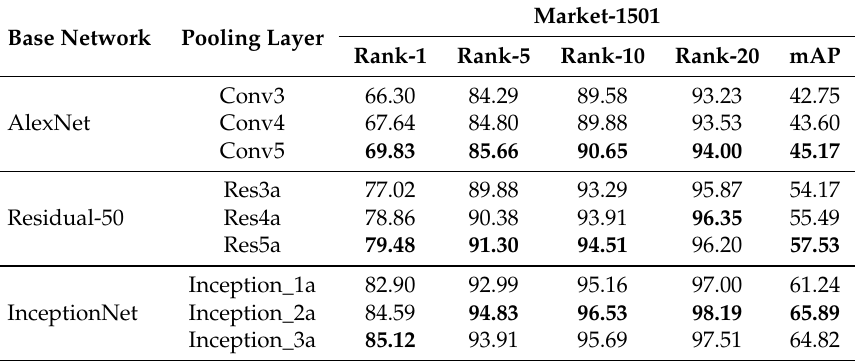
Table 8. Identification accuracy (%) and mAP (%) of the proposed method with performing RoI pooling at different middle layers on Market-1501. The best result over various pooling layers is marked in bold.